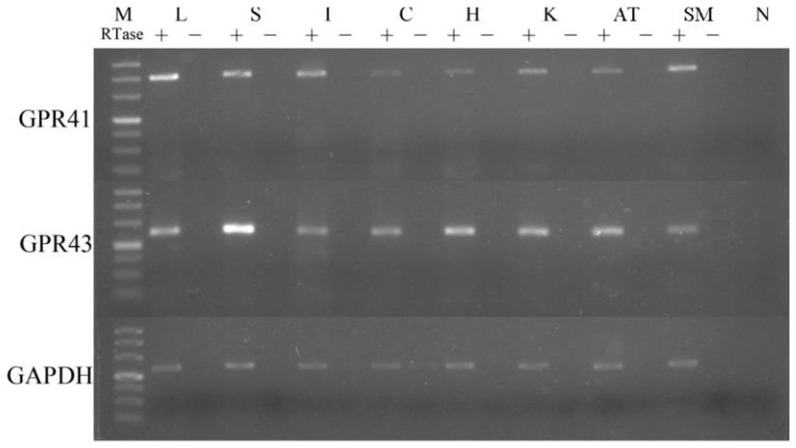
Expression of GPR41 and GPR43 mRNA in different porcine tissues at 160 day-old.The reverse transcription in the absence of reverse transcriptase (RTse –) was used to control for amplification from incompletely digested genome DNA. The GAPDH mRNA served as a loading control. The sizes of GPR41, GPR43 and GAPDH PCR products were 398 bp, 249 bp and 220 bp, respectively. The bands of the marker were 50 bp, 100 bp, 150 bp, 200 bp, 300 bp, 400 bp, and 500 bp from bottom to above. M: marker; L: liver; S: spleen; I: ileum; C: colon; H: heart; K: kidney; AT: adipose tissue; SM: skeletal muscle.